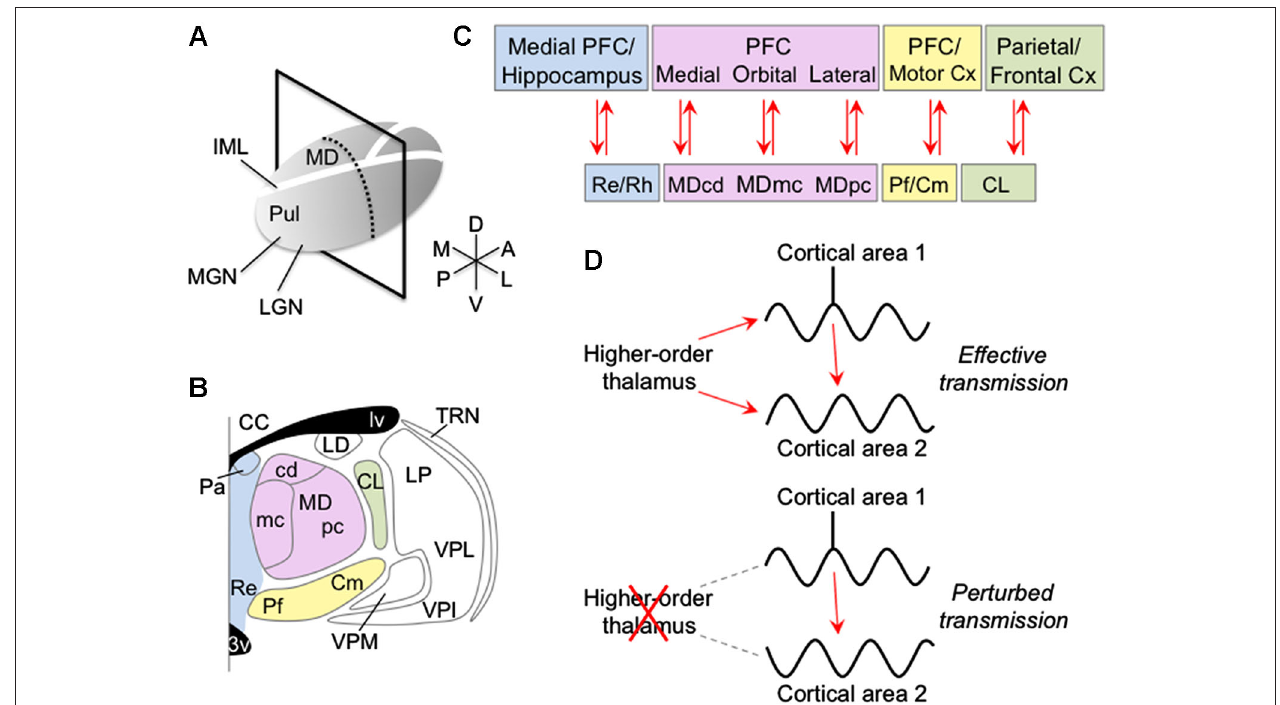
information transmission, either by reducing transmission efficacy with possible information degradation (bottom), or by erroneously routing information across cortex. Abbreviations: 3v, third ventricle; CC, corpus callosum; CL, central lateral nucleus; Cm, centromedian nucleus; Cx,